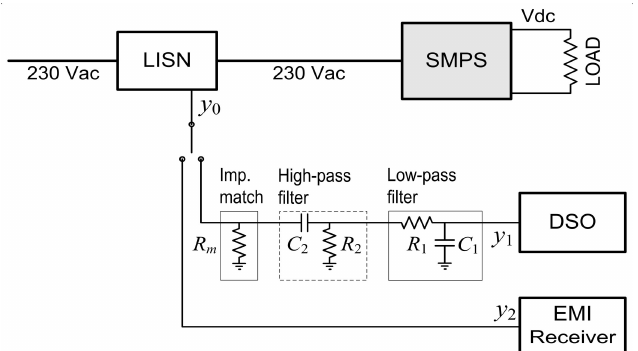
Figure 1. Scheme of the experimental setup: SMPS under test and its dc variable load, LISN (Line Impedance Stabilization Network), 50 Ω impedance matching, high-pass filter (1 kHz cuto ff ) and low-pass filter (2 MHz cuto ff ), Digital Storage Oscilloscope (DSO) and EMI Receiver.